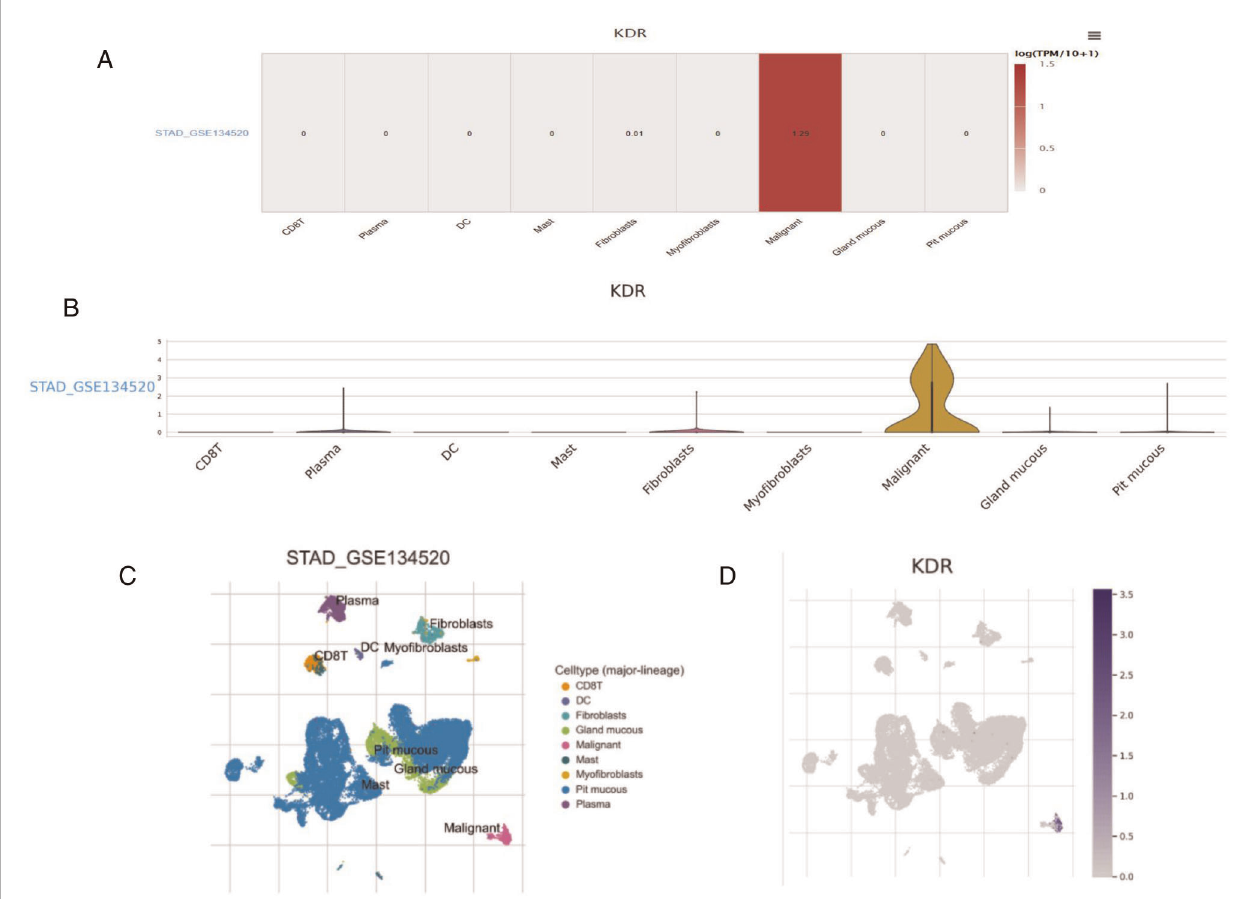
FIGURE 4 | Research results of VEGFR at single cell level. ( A ) Heatmap displays the value of VEGFR expression in different cells from database. ( B ) Violin diagram displays the distribution of VEGFR expression in different cells from database. ( C,D ) Single-cell cluster map of VEGFR in different